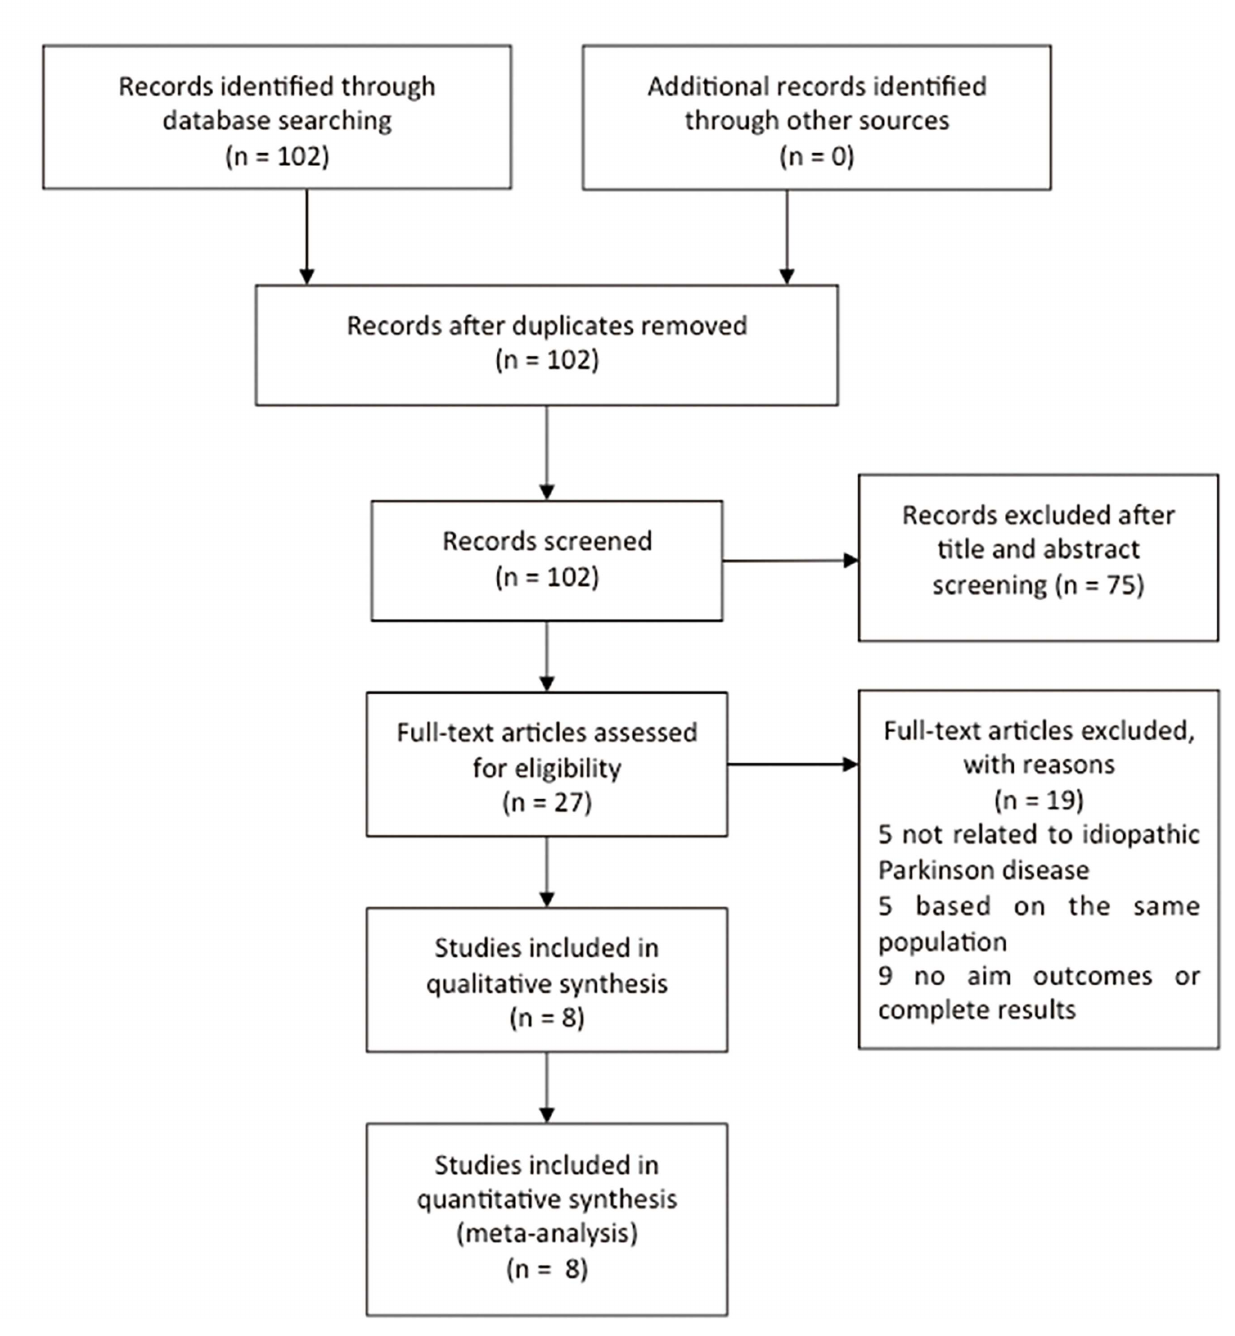
Fig 1. PRISMA flow chart of literature searchesand